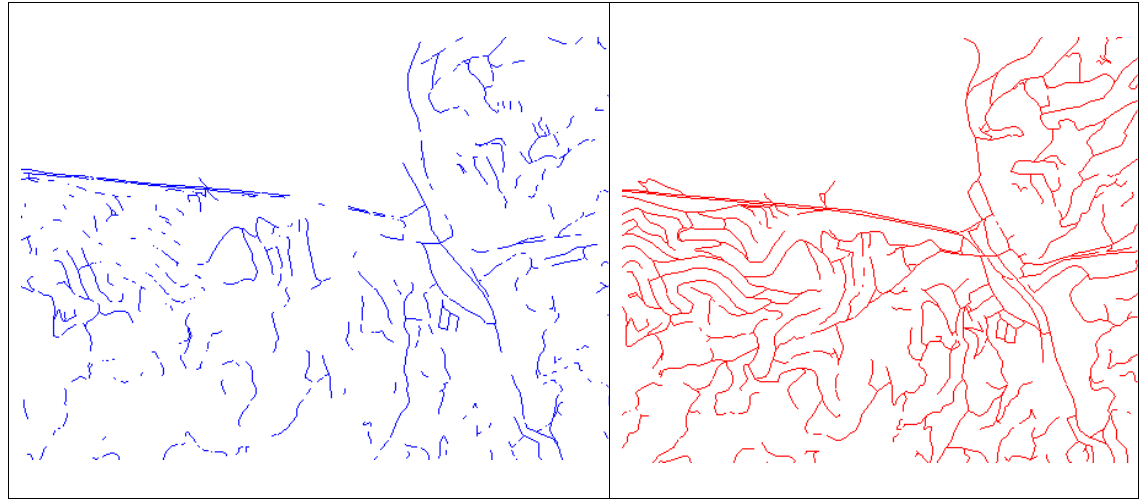
Figure 7. GIS Based analysis of on-screen manual digitizing results of the roads from IKONOS imageries. (2002 is left, 2008 is right).